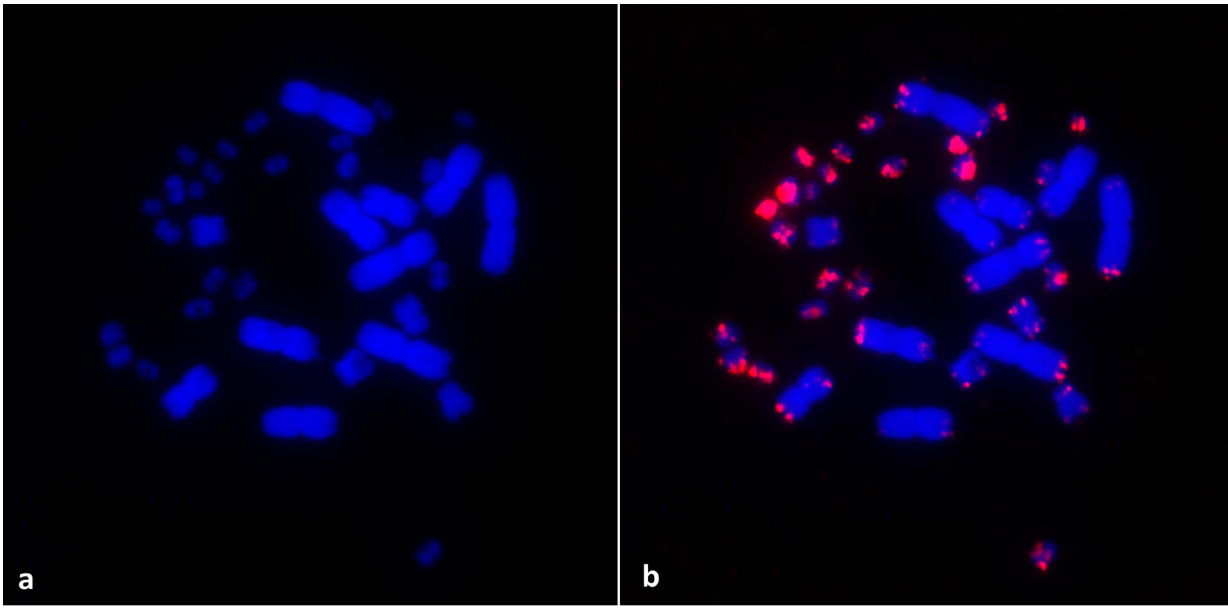
Figure 4. DAPI stained metaphase chromosomes (a) and the results of fluorescent insitu hybridization with the telomeric probe (TTAGGG) n (b) in a female of Helodermasuspectum .